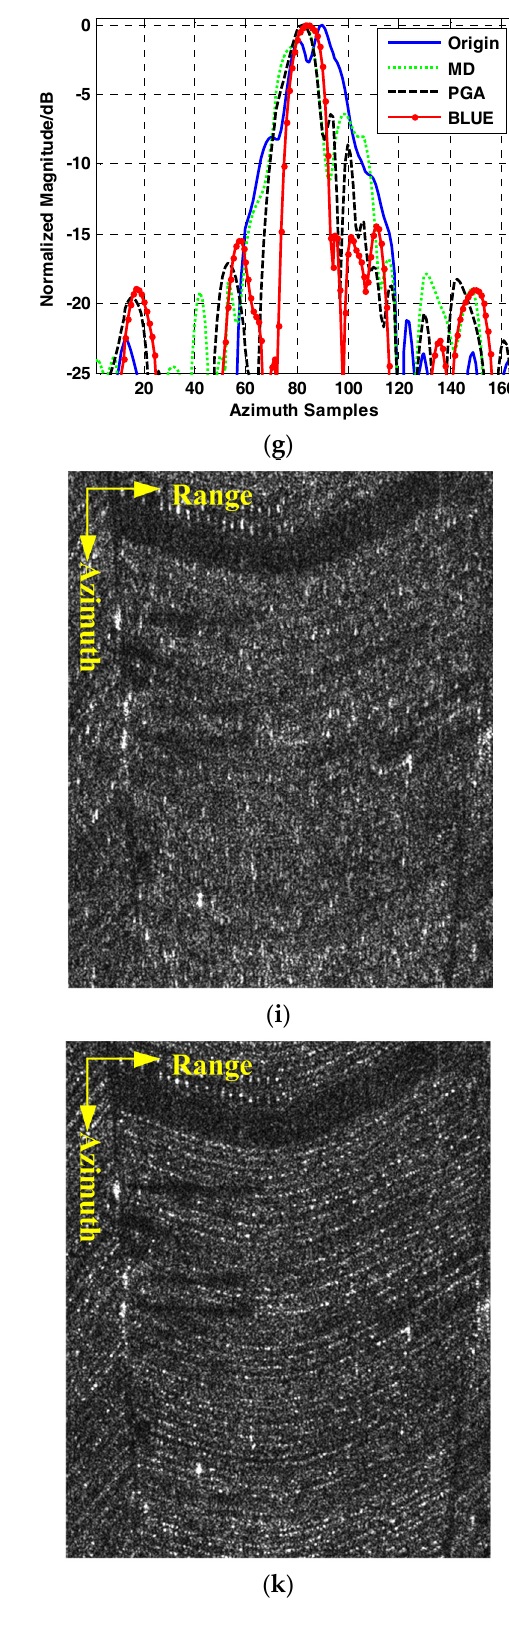
Figure 18. Actual SAR image and analysis. ( a ) Full scene image, and close views of the yellow rectangle processed using ( b ) CS, ( c ) MD, ( d ) PGA, and ( d ) BLUE algorithms. ( f , g ), represented by linear and log, are azimuth slices of the corner reflector marked with a yellow rectangle in ( b – e ). ( h – k ) are close views of the yellow ellipse processed by the CS, MD, PGA, and BLUE algorithm, respectively. The azimuth direction is vertical.